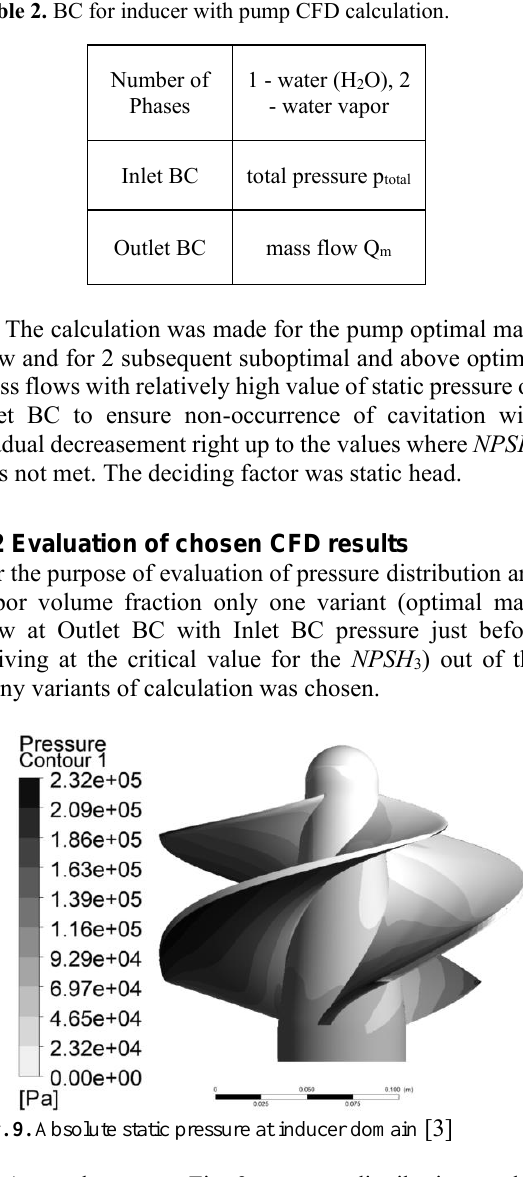
Table 1. BC for inducer alone CFD calculation.